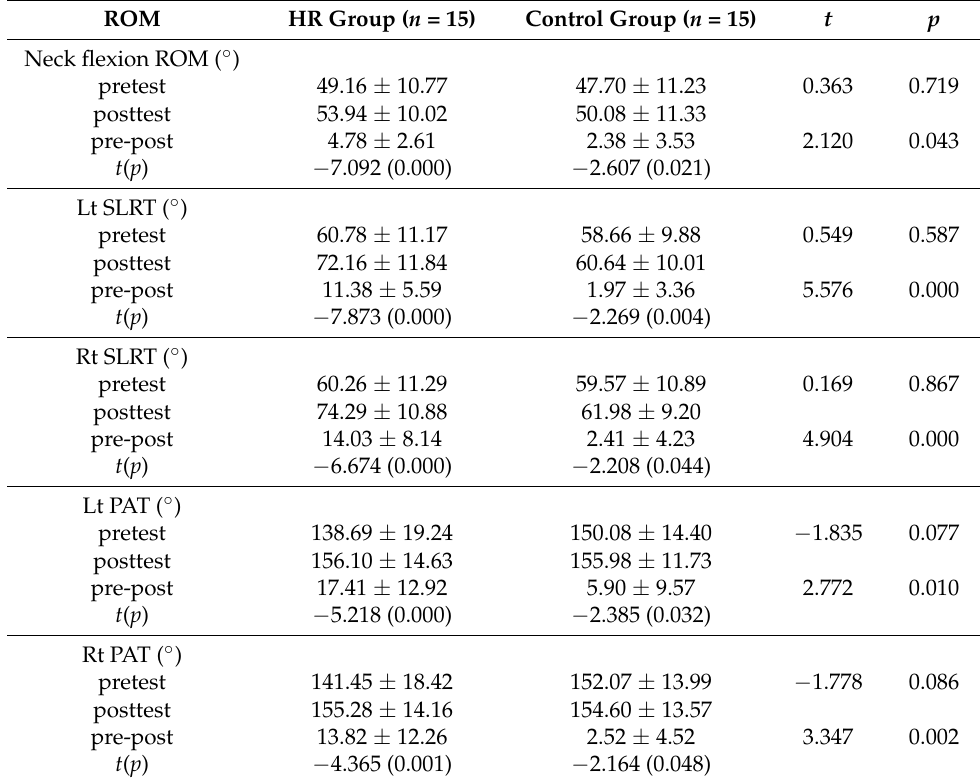
Table 4. Comparison of the range of motion (N =